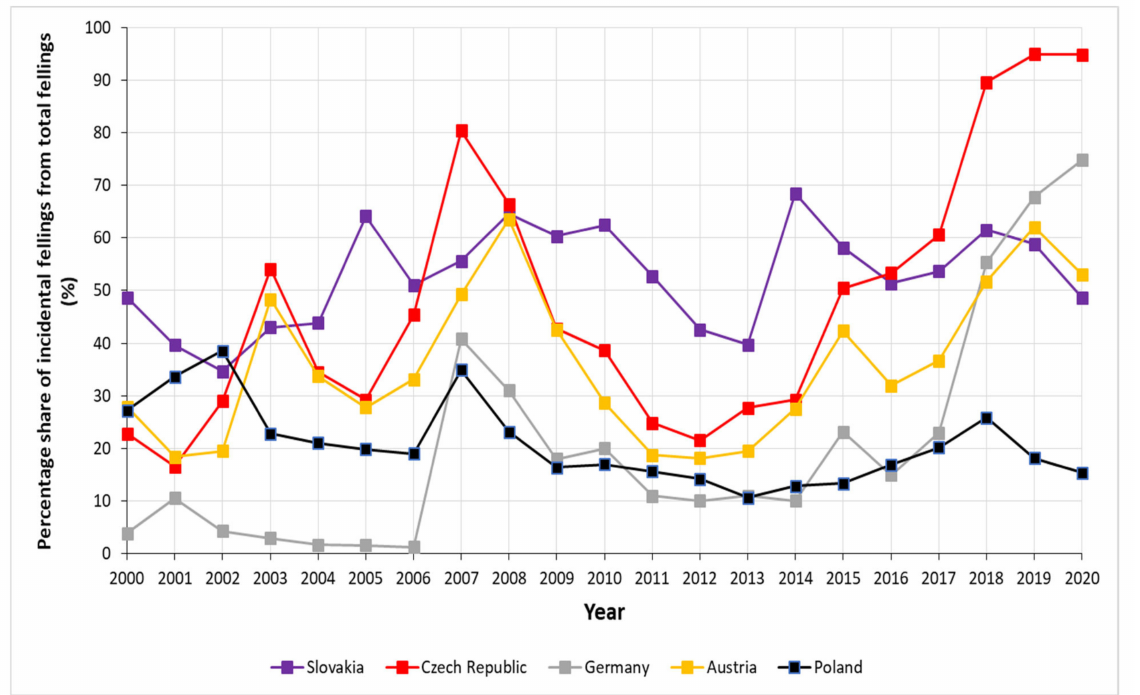
Figure 4. Percentage share of incidental fellings from the volume of total timber harvestings in selected European countries in the time range